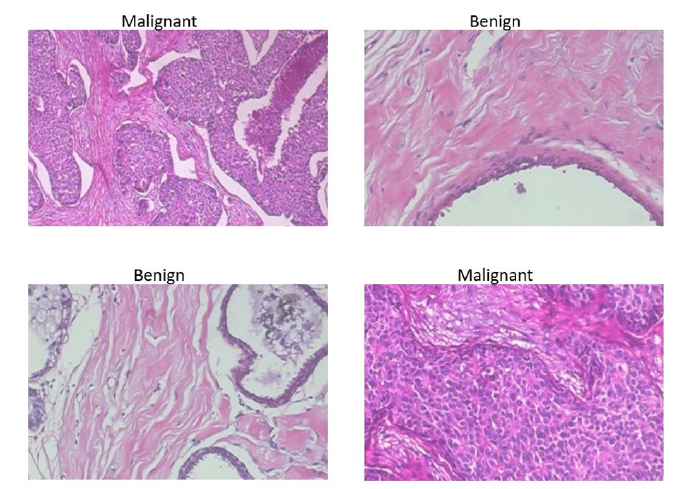
Figure 8. Examples of images after resizing to dimensions 224 × 224 × 3.